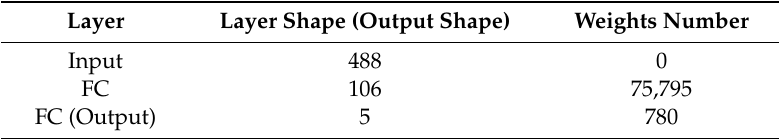
Table 3. The layer shape and weights number of FCNN.